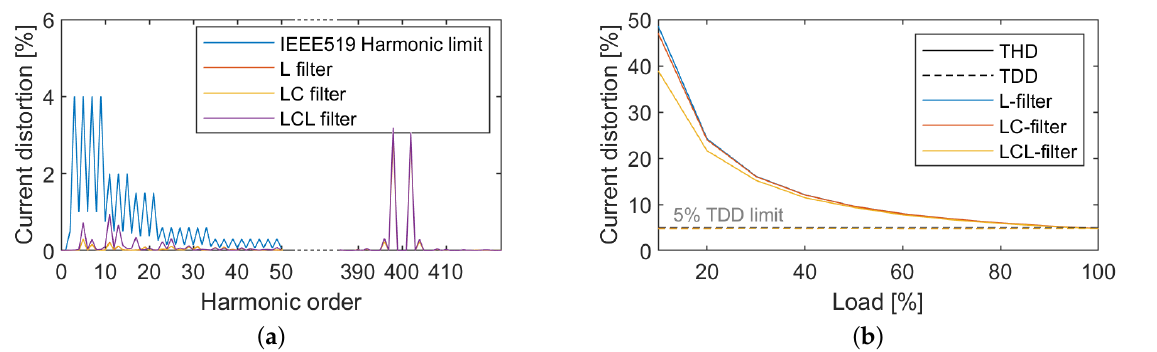
Figure 21. Harmonic analysis of the grid side current of 30 kW two-level AFE rectifier with an L/LC/LCL filter. ( a ) Individual harmonics compared to the IEEE 519-2014 limits. ( b ) THD and TDD from simulation compared to the IEEE 519-2014 TDD limit.